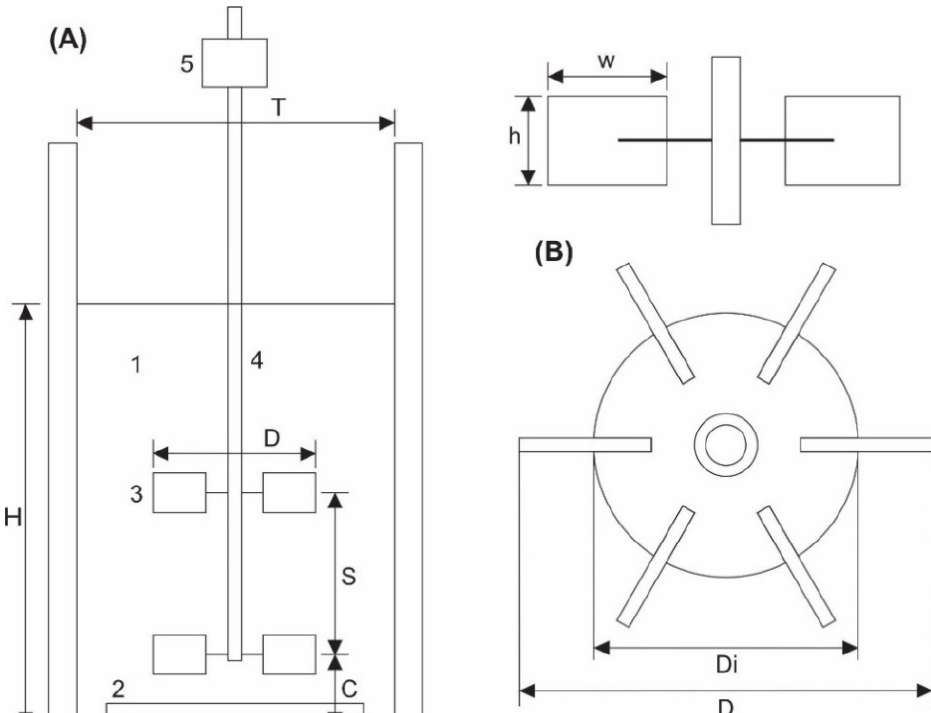
Figure 1. ( A ) Schematic representation of the stirred tank reactor (1. stirred tank, 2. ring-type bubble diffuser, 3. Rushton impeller, 4. Axis and 5. Rotation sensor), with the geometric proportions (H/T = 1.35, D = T/2, C = T/4, S = T/2). ( B ) Rushton impeller sketch with six blades to shaft (w/D = 1/3, h/D = 1/4, Di/D = 2/3). Schematics were adapted from Luan et al. [45].